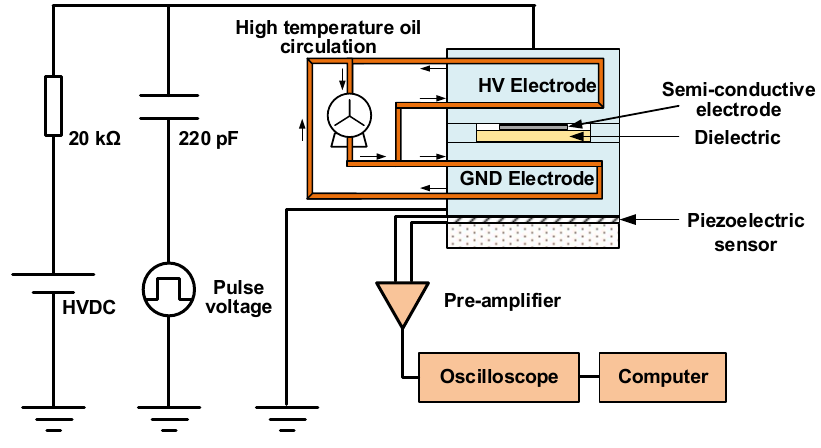
Figure 1. Schematic illustration of the experimental setup for PEA.